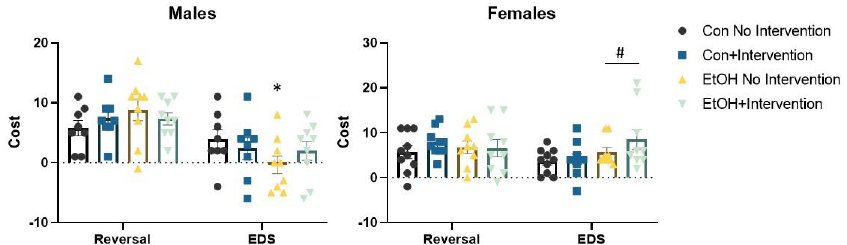
Figure 4. The reversal and shift cost for male and female rats. No significant effects on the reversal cost were detected. Analysis of the cost of the extradimensional shift (EDS) confirmed a main effect of sex, p = 0.002 and sex x prenatal treatment interaction, p = 0.01. Prenatal ethanol exposed male rats were less likely exhibit a positive shift cost, chi square analysis, *all p values < 0.035. The intervention significantly increased the number of rats exhibiting a shift cost. Prenatal ethanol did not change the number of females at exhibited an increased shift cost, but the cost was increased in females, regardless of the intervention, # p = 0.03. Con=Control, EtOH=Ethanol, EDS=Extradimensional Shift. 3.5. Functional Connectivity of the Infralimbic Cortex and Cerebellum Was Increased in Ethanol-Exposed Rats